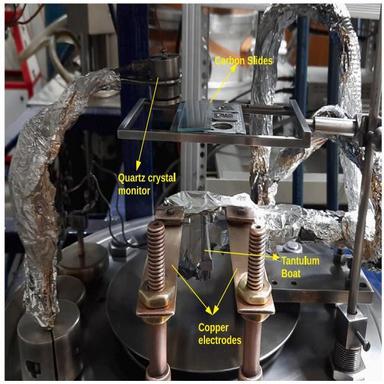
Diffusion pump based coating unit for deposition of tin.